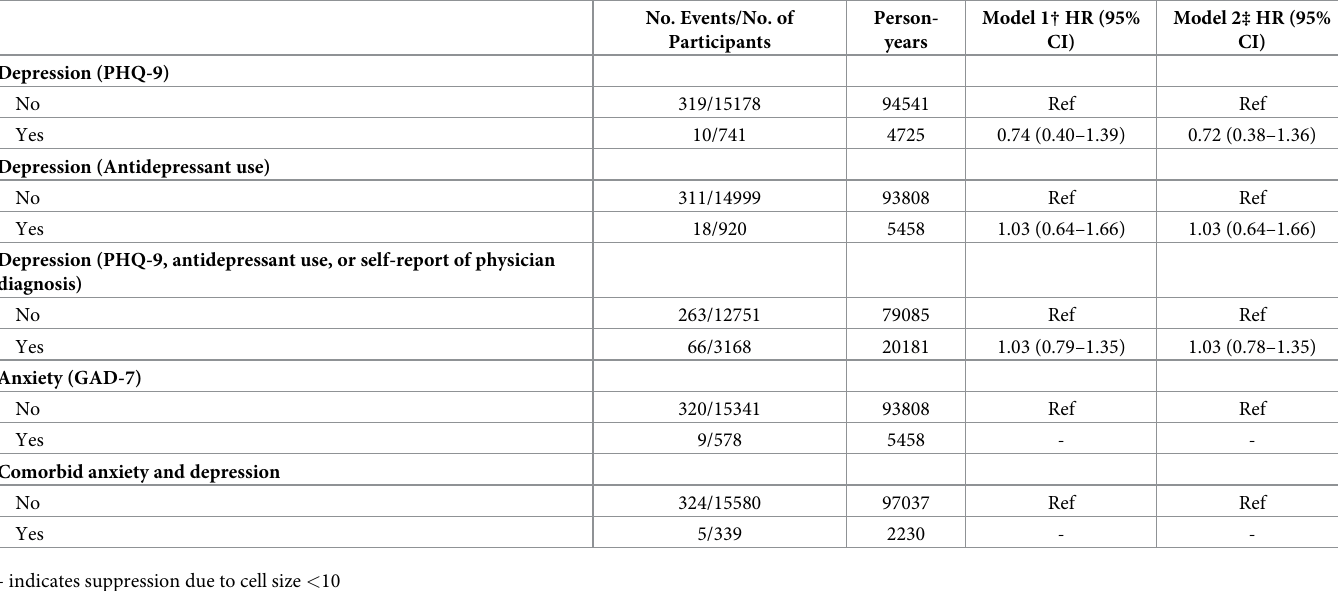
Table 5. Hazard ratios between mental health disorders and subsequent diagnosis of prostate